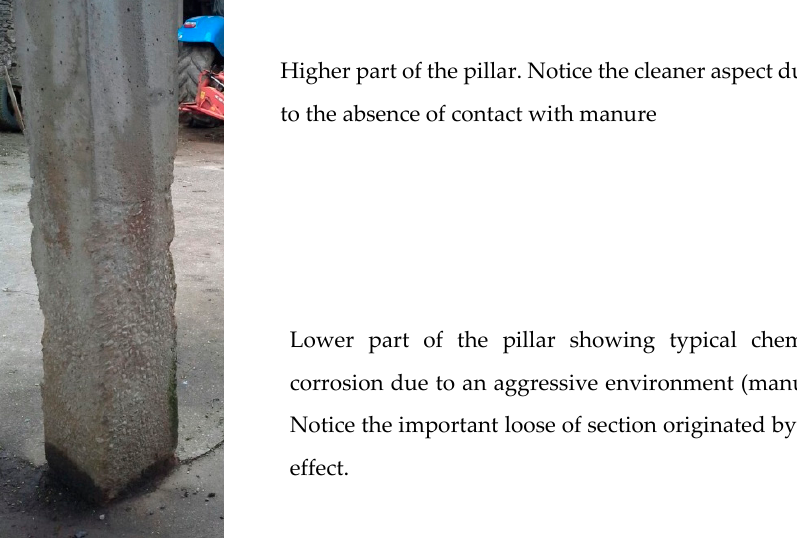
Figure 2. An image of a pillar showing typical deterioration by aggressive environment. Notice the loose of section in the lower part.